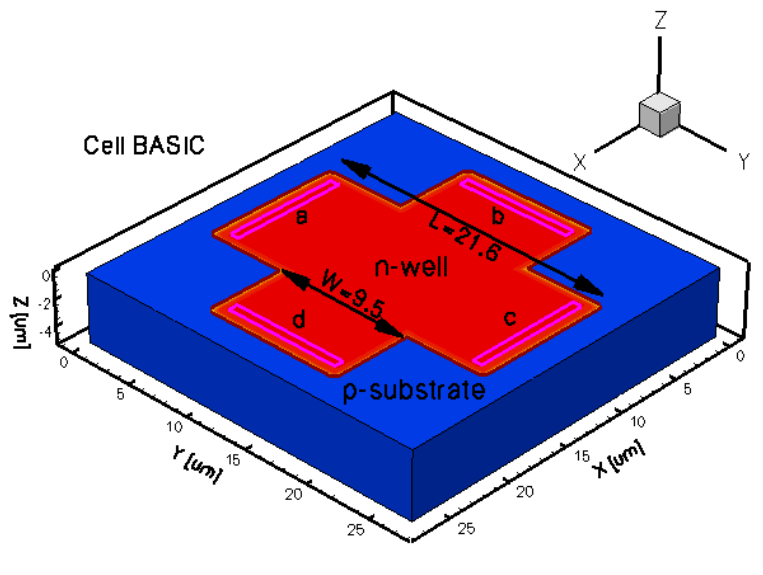
Figure 2. 3D representation of the simulated basic Hall